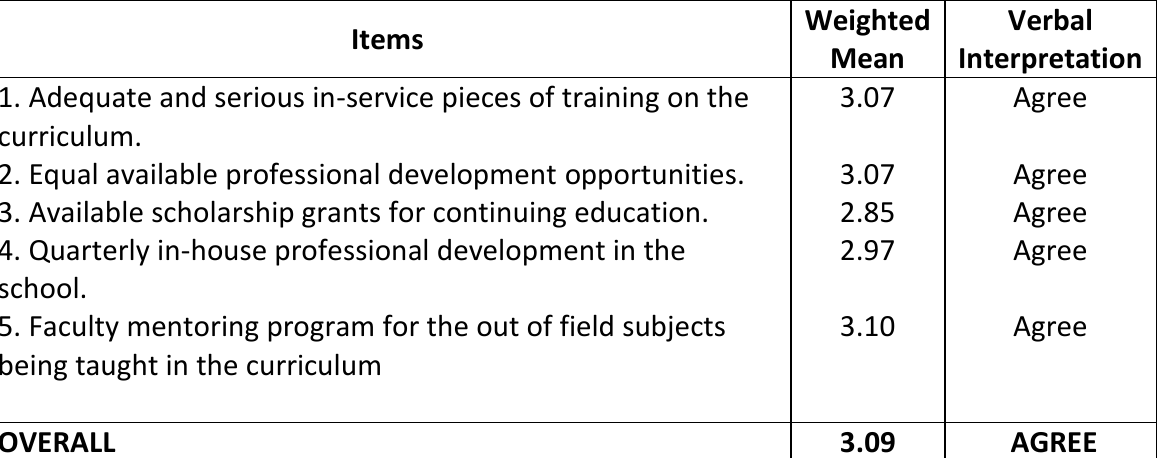
Table 8 : Weighted Means of the Factors Affecting Students’ Progress as to Teachers’